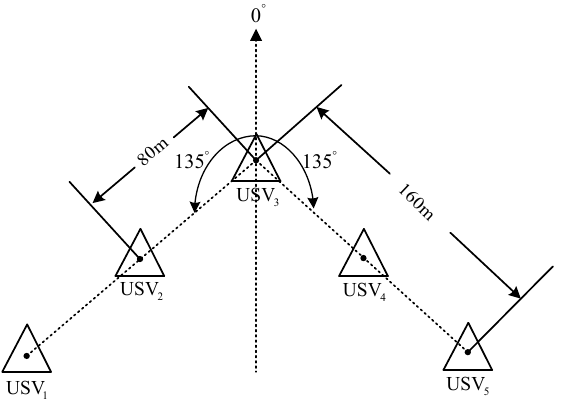
Figure 16. Schematic diagram of formation.